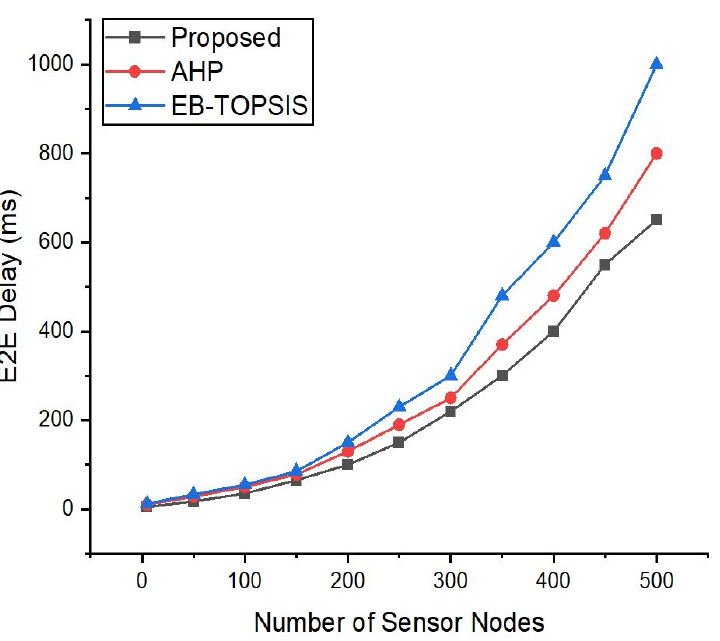
Figure 5. Delay recorded while traffic generation and increasing the sensor